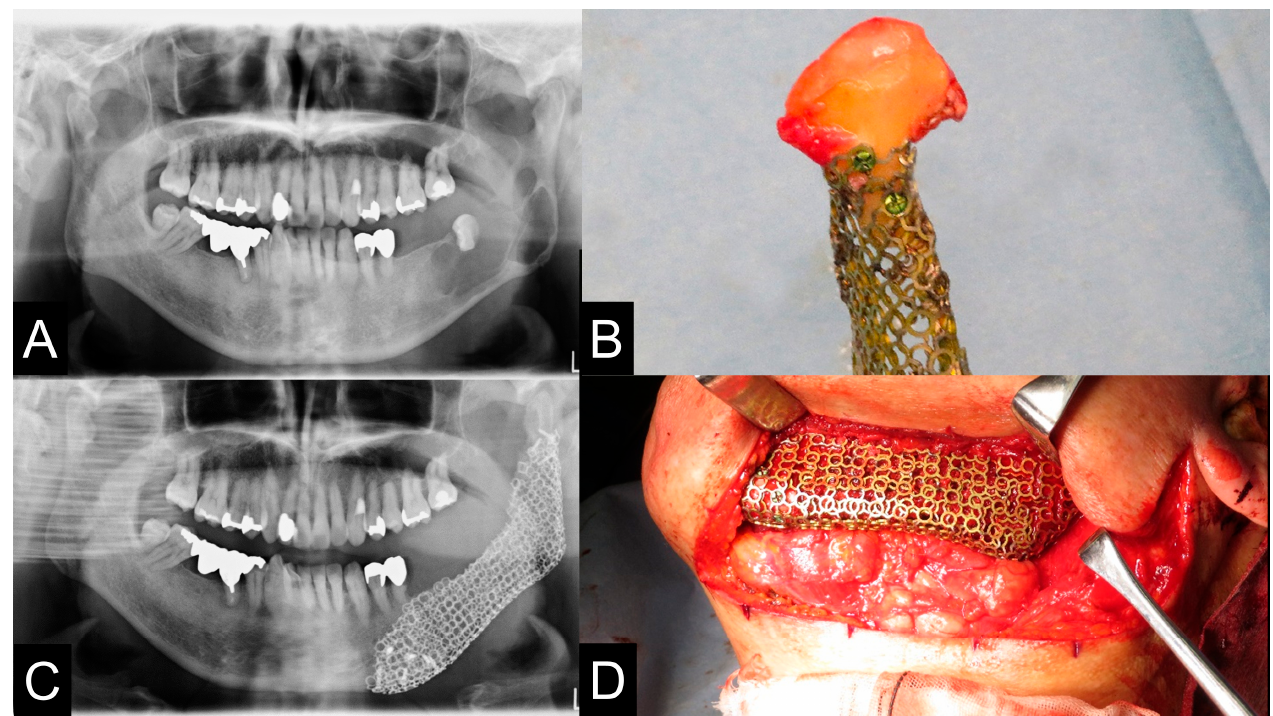
Figure 9. Pre- and postoperative panoramic radiographs showed accurate jaw reconstruction. ( A , C ). The mandibular condyle was removed once ( B ) and a PCBM was implanted directly fixed to the pre-bended TiMesh ( D ). The patient refused prosthodontic treatment because he did not feel any difficulty in masticatory function.